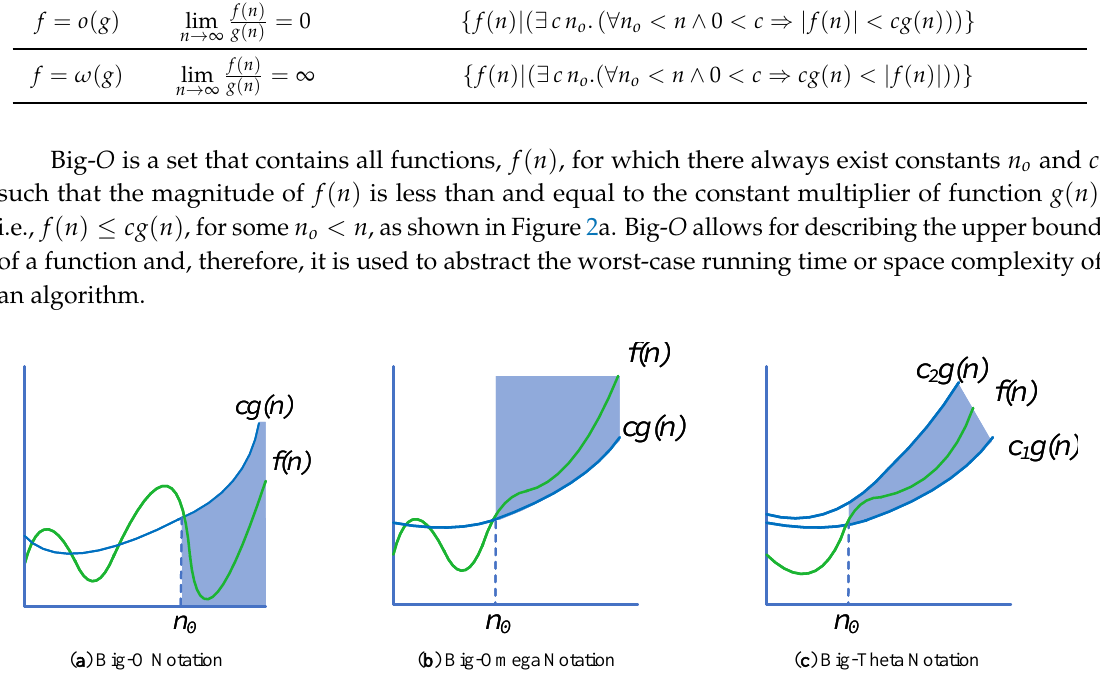
Figure 2. Asymptotic upper, lower and tight bounds of a function (from ( a – c